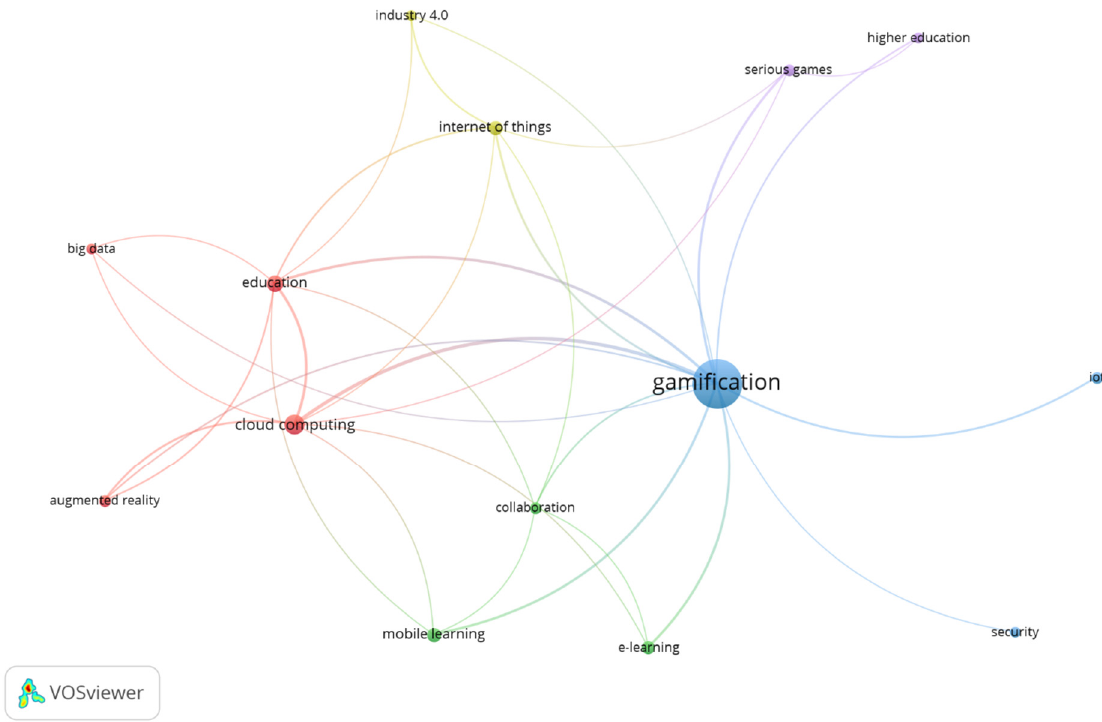
Figure 6. Labelled bibliometric map.